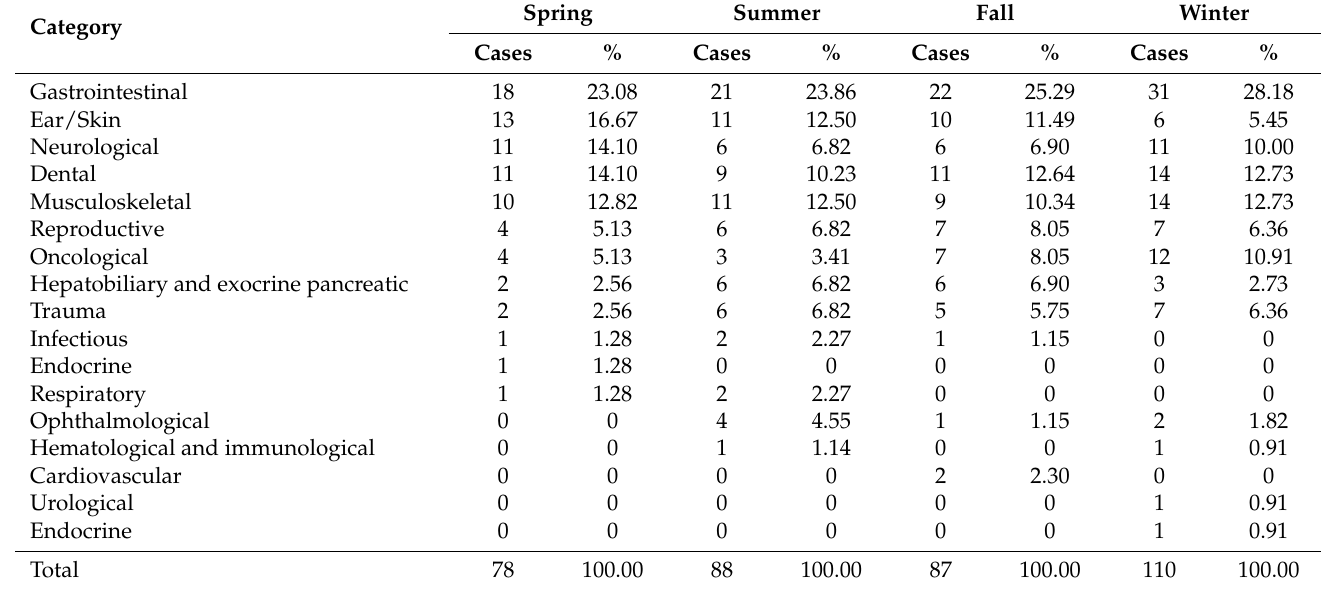
Table 5. Disease categories by season.